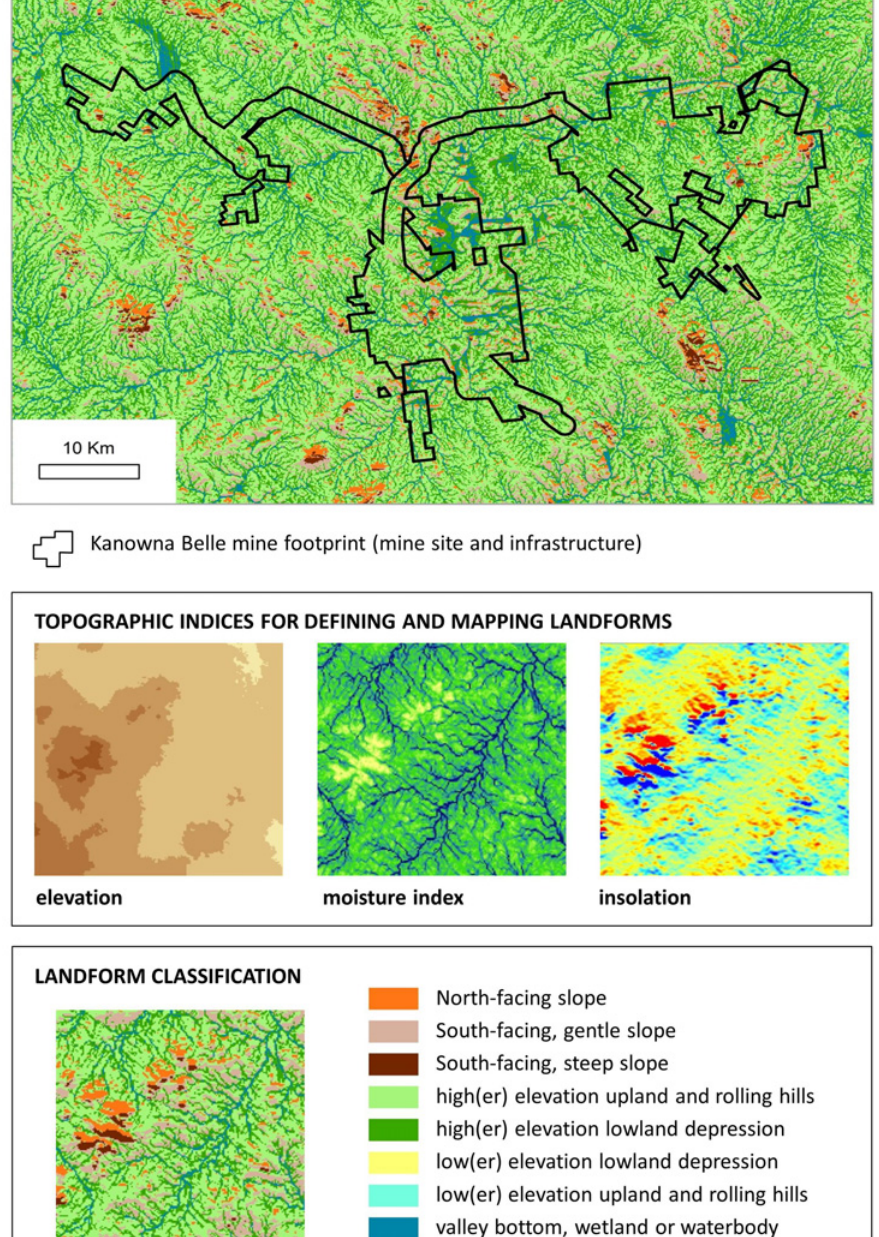
Figure 3. Landforms defined and mapped according to a cluster analysis of elevation, insolation [38] and a topographic index